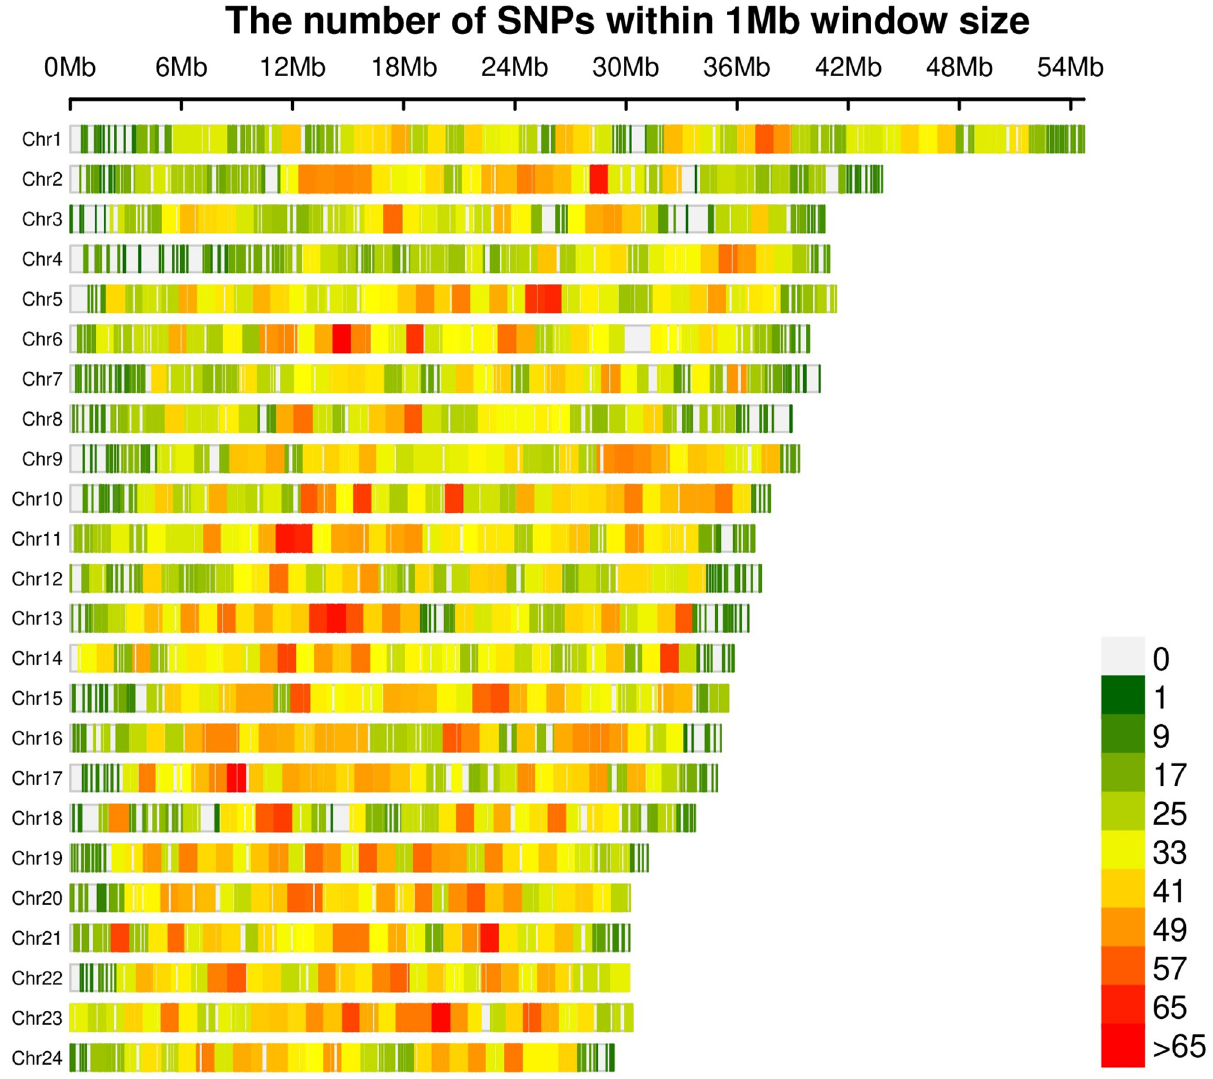
Fig 1. Distribution diagram of SNP markers in the chromosomal